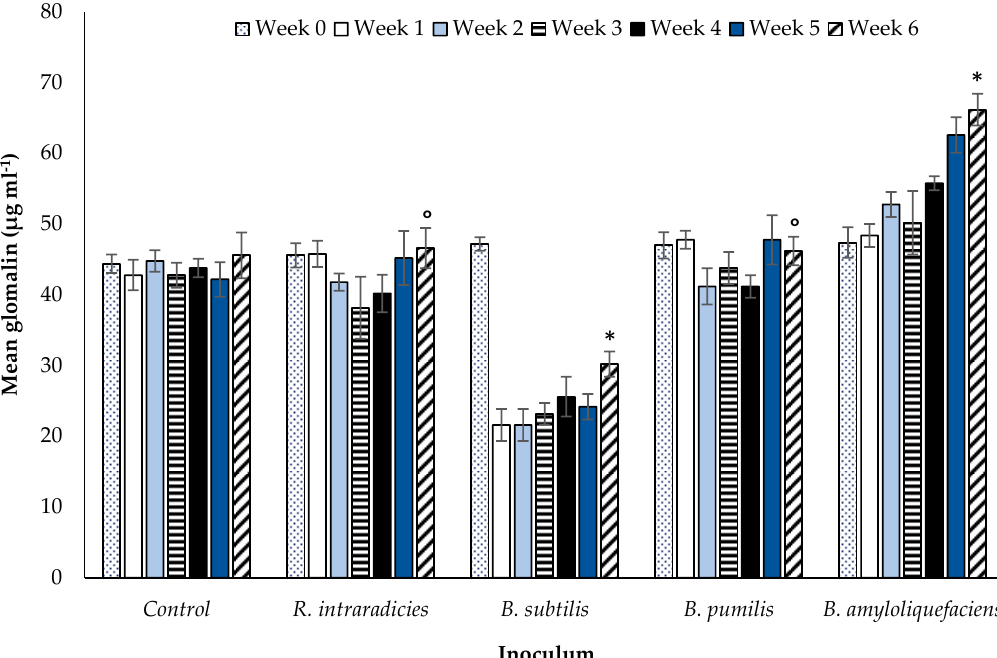
Figure 8. Mean ( n = 175 overall) glomalin concentration ( µ g mL − 1 ) comparing inoculated and a non-inoculated control sandy loam top soil ( < 10 cm) extracted from a CT managed field over a six week period under controlled glasshouse conditions. TRUE Bonferroni corrections (*), FALSE Bonferroni corrections (°). Error bars = one SEM.